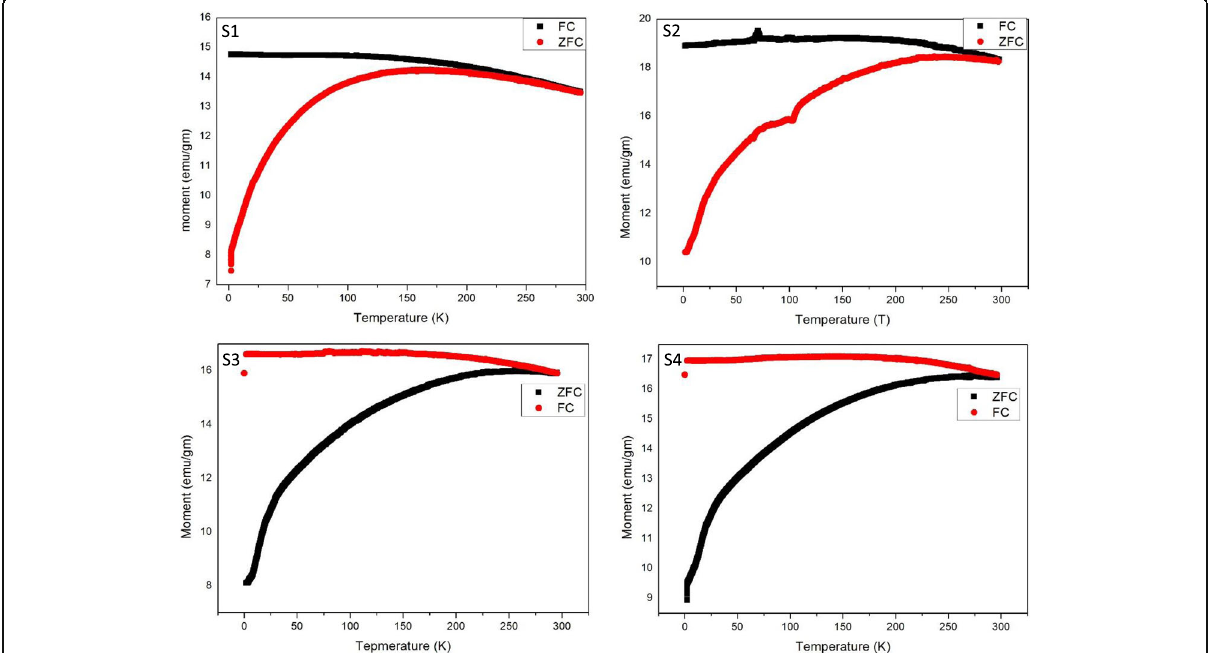
Fig. 5 Magnetisation vs temperature plot of different Fe 3 O 4 samples (S1-S4)